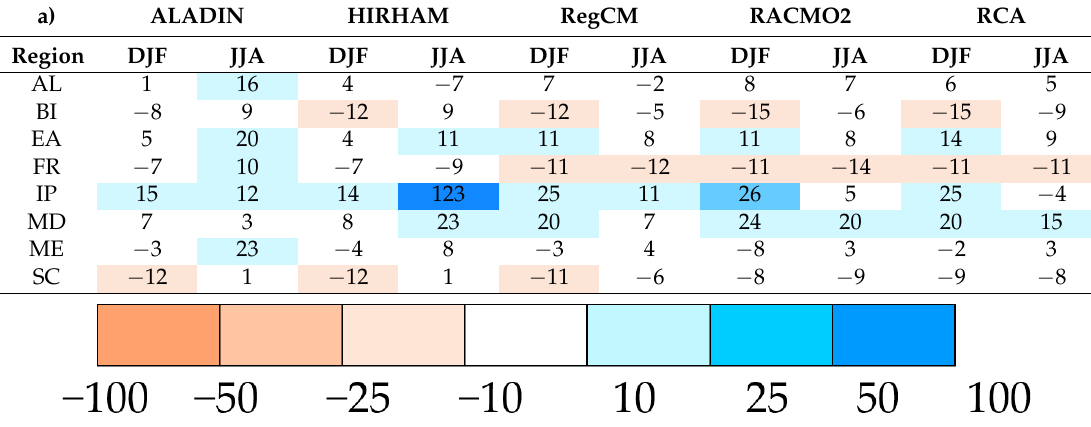
Table 9. Residual bias of seasonal amount of simulated precipitation (a) in the case of power transformation of precipitation and the seasonal mean of the simulated temperature, (b) in the case of variance scaling of the temperature bias correction methods in the test period in eight different regions: the Alps (AL), the British Isles (BI), Eastern Europe (EA), France (FR), the Iberia Peninsula (IP), the Mediterranean (MD), Mid-Europe (ME) and Scandinavia (SC) in DJF and JJA. The bias values are in % and in °C for precipitation and temperature, respectively.